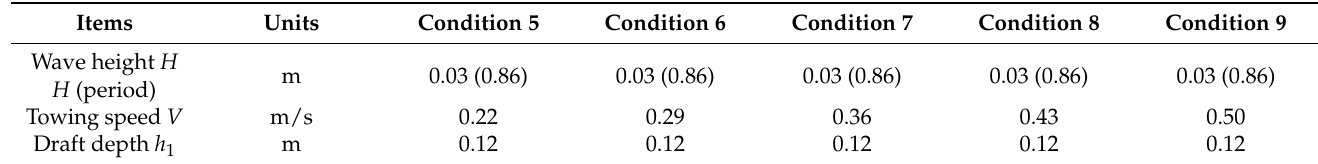
Table 6. Wet-towing conditions (speed as main variable).